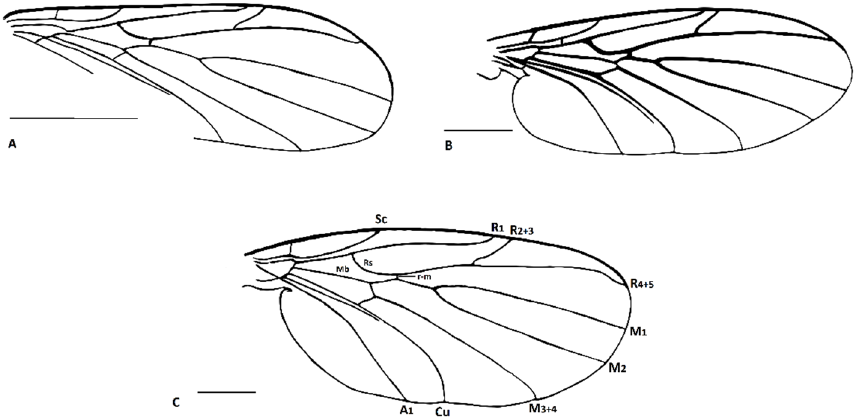
Figure 3. Wing of Paleoplatyura agnieszkae sp. nov. ( A ), P. miae sp. nov. ( B ), and P. magnifica sp. nov. ( C ). Scale bar = 0.5 mm.